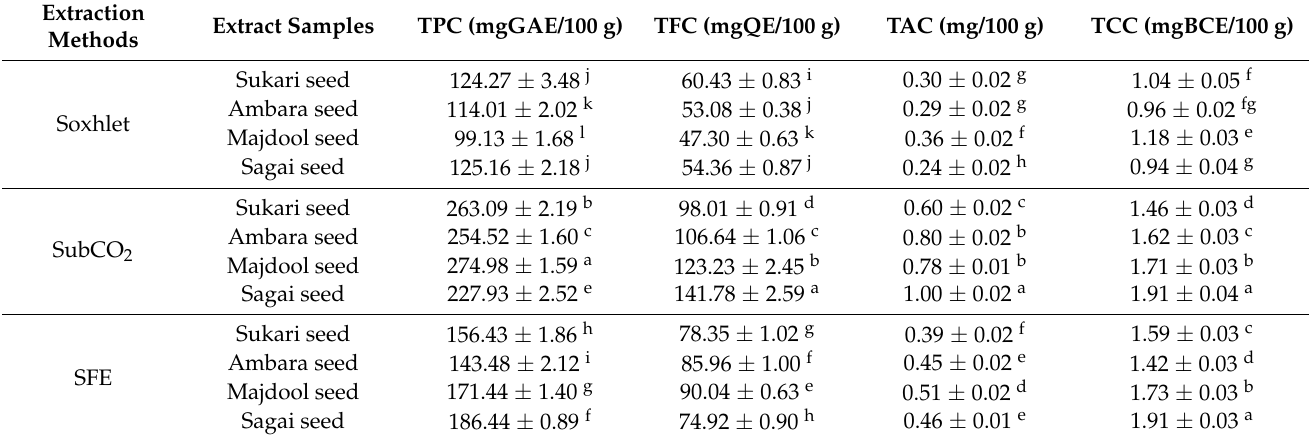
Table 3. Phytochemicals and total antioxidant compounds of date seed extracts obtained by using different extraction